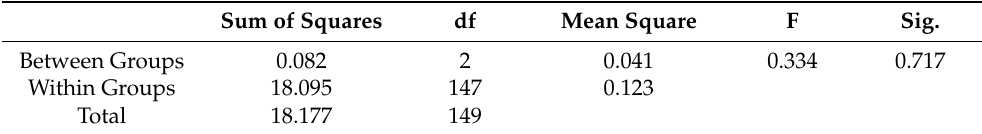
Table 4. ANOVA—40 m shuttle